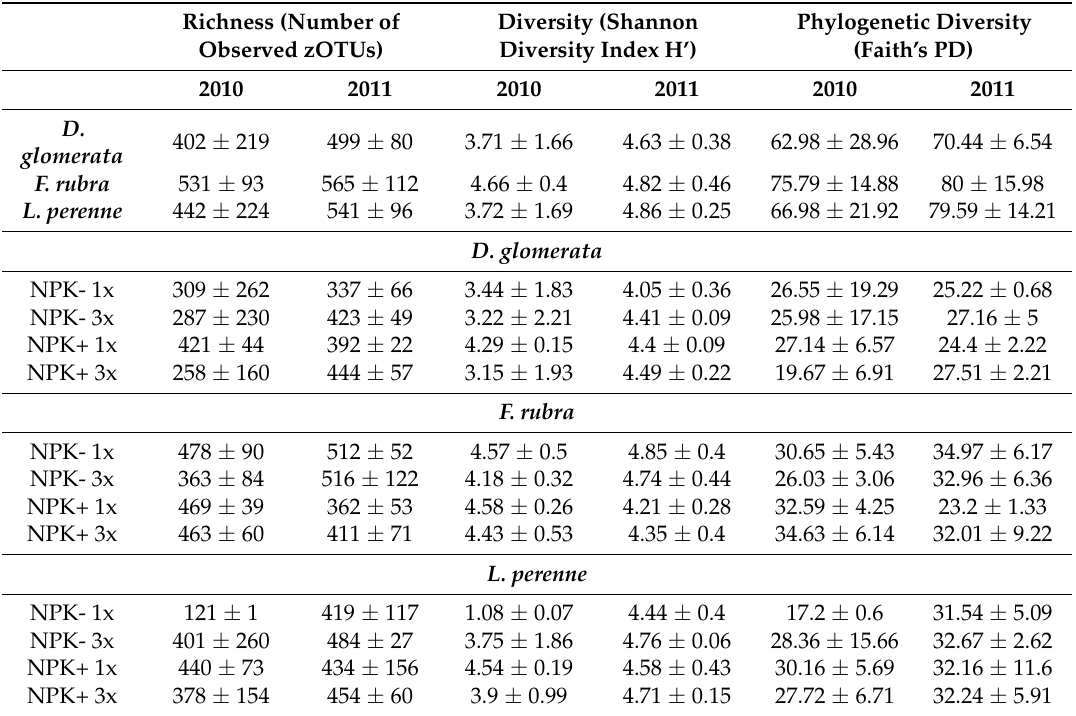
Table 1. Alpha diversity of fungal endophyte communities in D. glomerata , F. rubra and L. perenne under different management levels in 2010 and